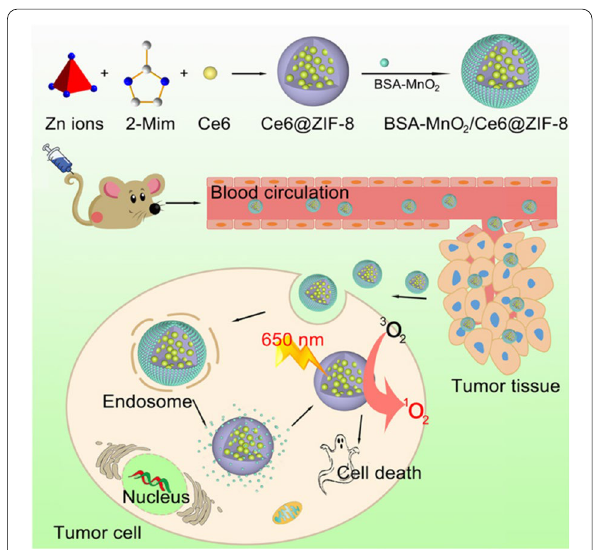
Fig. 3 Schematic illustration for the Formation of a BSA-MnO 2 /Ce6@ ZIF-8 Nanoplatform and Schematic Illustration Showing the TME Responsiveness and Generation of ROS Irradiation upon 650 nm NIR Laser for MRI-Guided Photodynamic Cancer Treatment